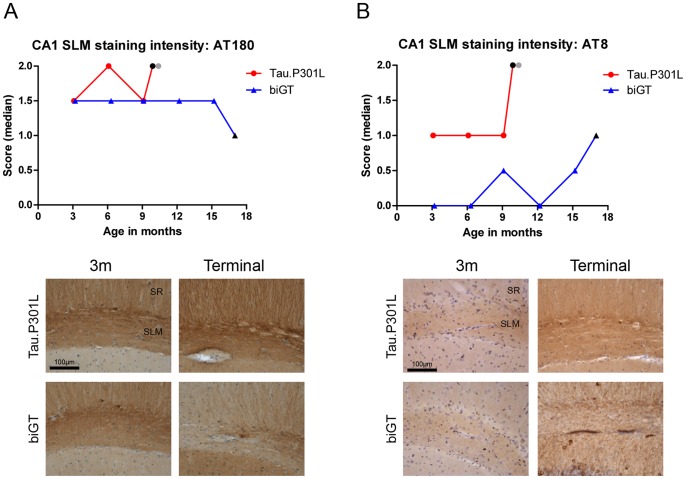
Timeline of phospho-Tau in the CA1 SLM of Tau.P301L and biGT mice.IHC for AT180 (A) and AT8 (B) staining in CA1 SLM region of Tau.P301L and biGT mice at ages 3, 6 and 9 months and terminal. Data are represented as median intensity score for immunoreactivity with AT180 (A) and AT8 (B) in CA1 SLM. Grey symbols denote mice with clasping and black symbols denote terminal mice (see text for details)(n = 6–8 mice per age group). CA1 hippocampal sub-regions stratum radiatum (SR) and stratum lacunosum molecular (SLM) are marked.